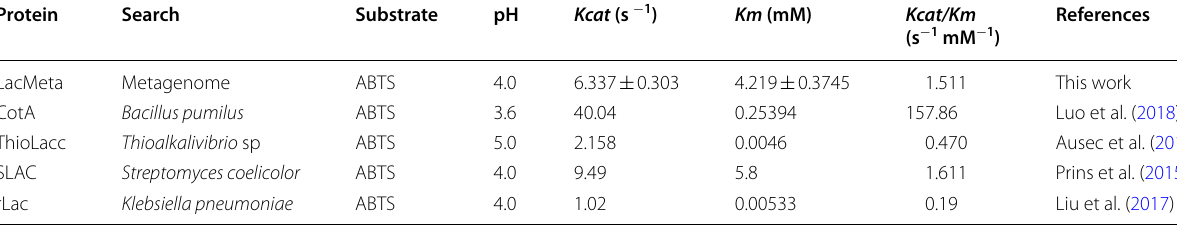
Table 1 Comparison of Kcat, Km and Kcat/Km with other laccases described in the literature Protein Search